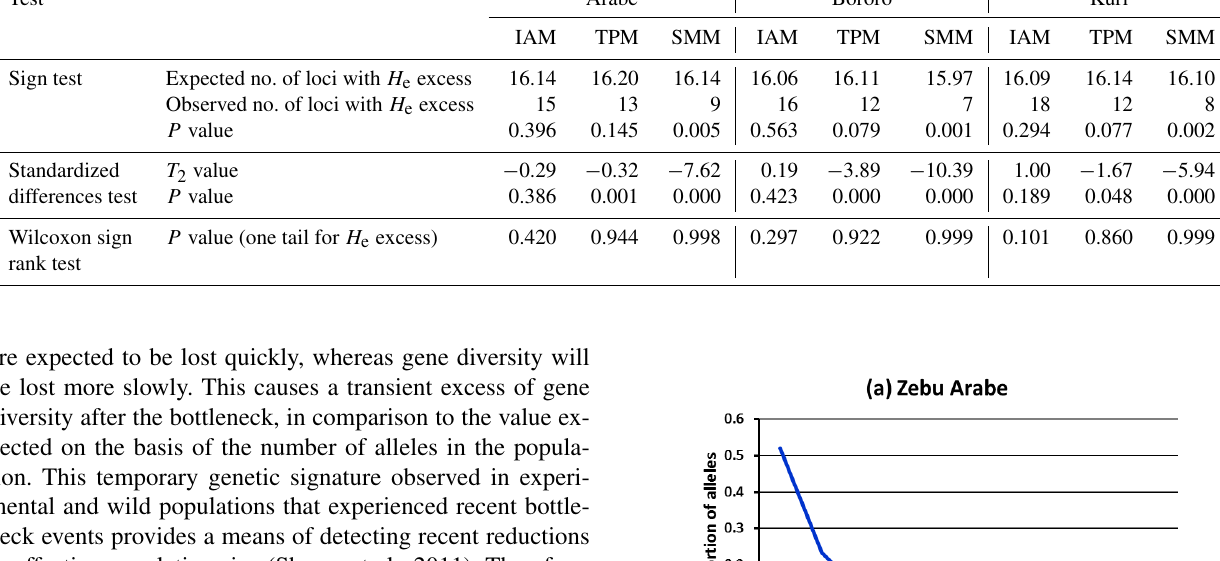
Table 5. Tests for mutation drift equilibrium in Zebu Arabe, Zebu Bororo and Kuri breeds of Niger cattle. Test